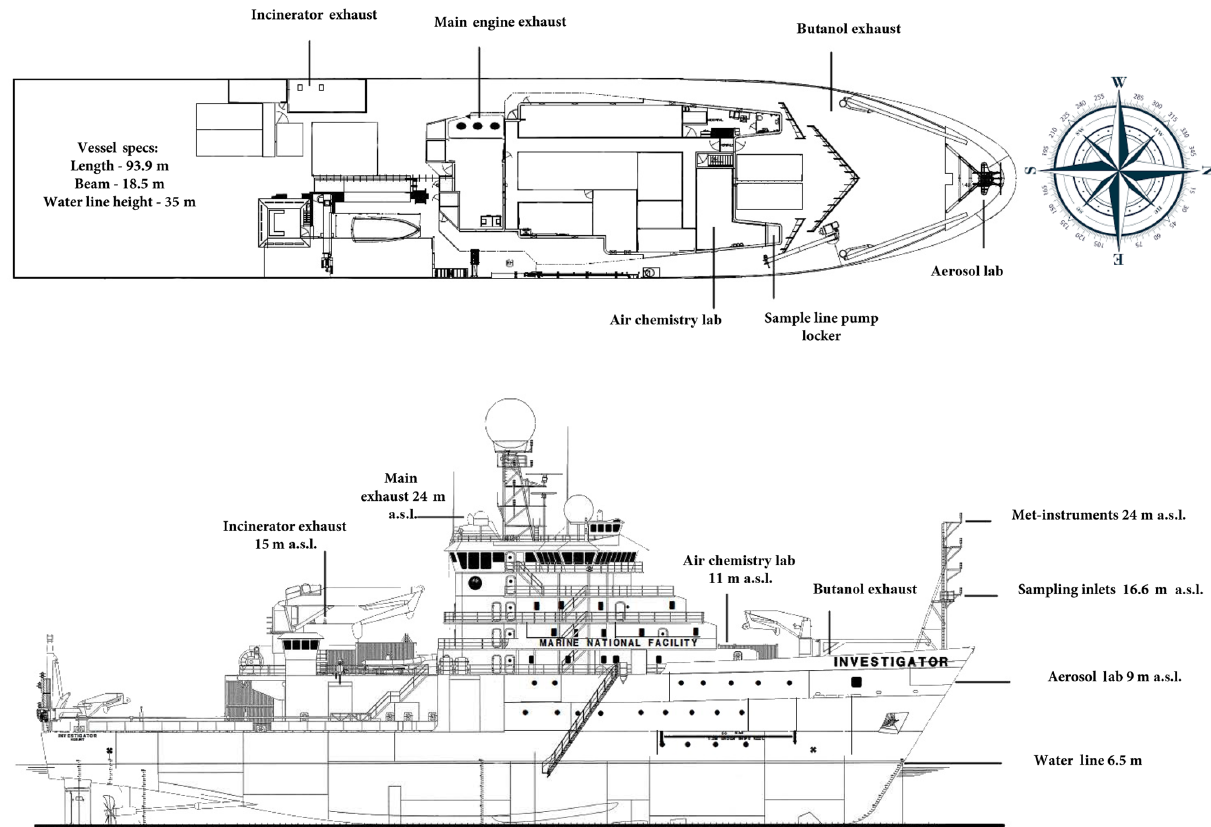
Figure A5. A schematic of the ship, with the two exhaust pipes marked – the main engine and the incinerator, along with the location of the main sampling inlets and met instruments on the foremast. Measurements of aerosol parameters (CN, BC and CCN) are carried out in the aerosol lab, while greenhouse gas measurements (CO and CO 2 ) are carried out in the air chemistry lab. The compass on the bird’s eye view is oriented to show the wind direction as measured relative to the